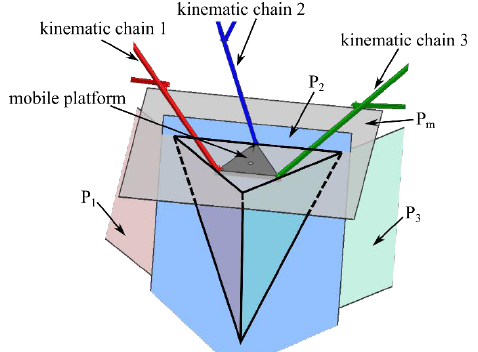
Figure 6. Characteristic tetrahedron for the 6-DOF parallel robot for SILS (nonsingular